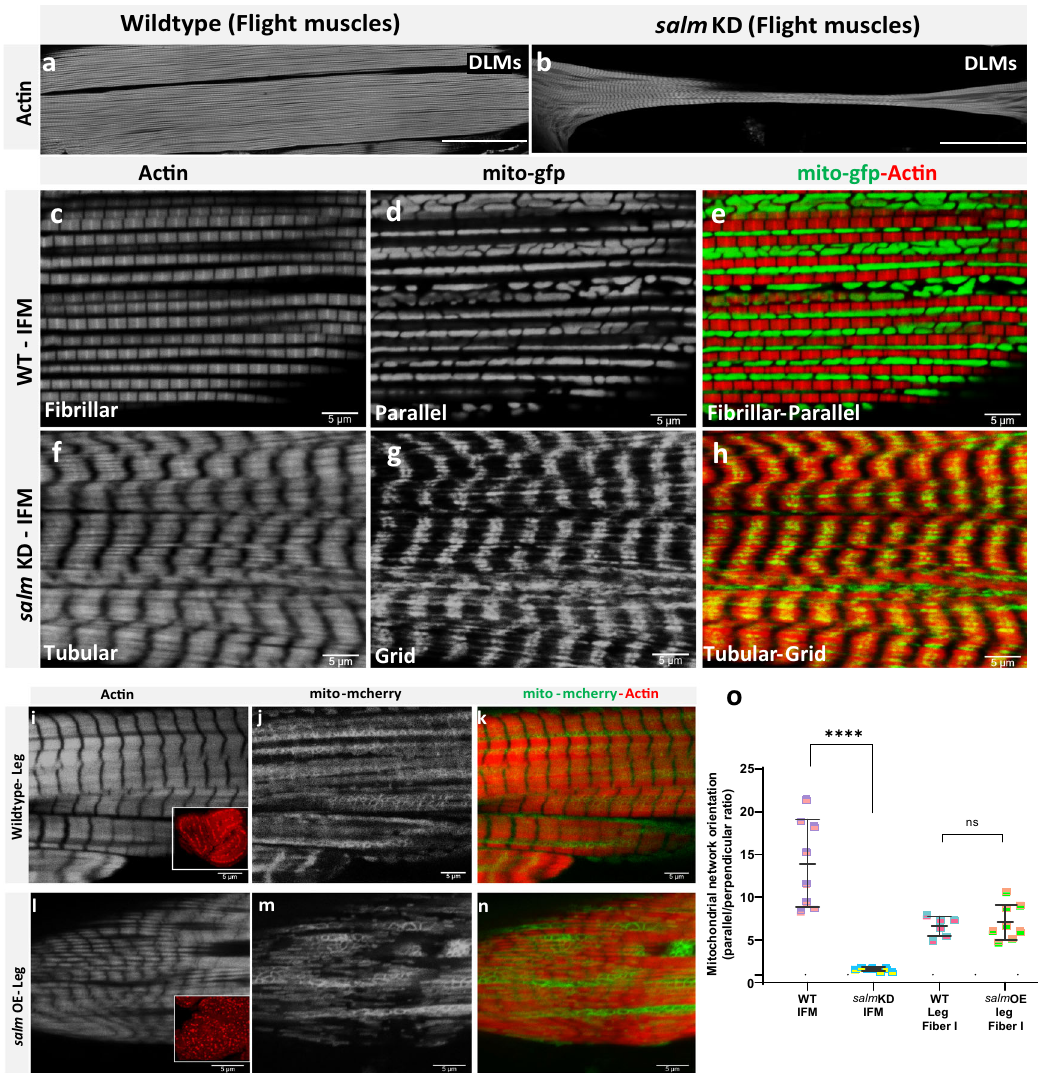
Fig. 2 | salm regulates conversion of muscle fi ber contractile type and mito- chondrial network orientation. a Adultwild-type fl ight muscles ( fi brillar) stained for F-actin (phTRITC). b salm KD muscle fi ber stained for muscles showing